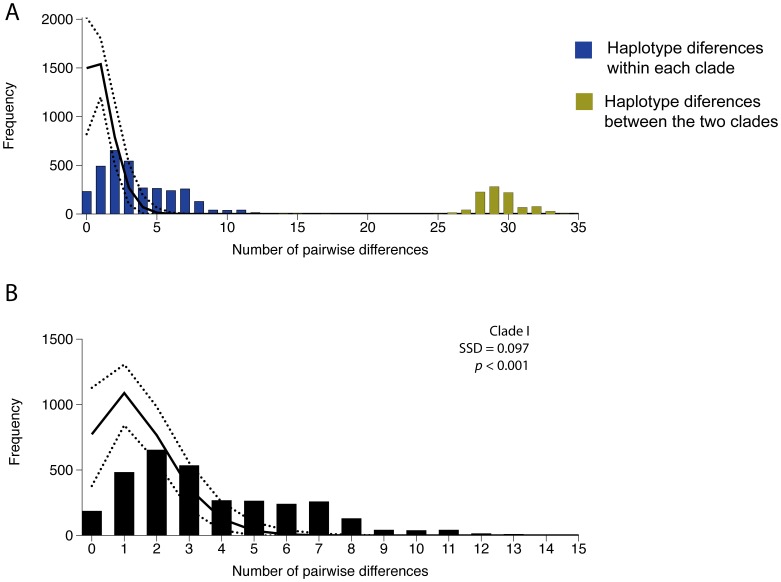
Pairwise mismatch distributions using the CR mtDNA data set.(A) mismatch distribution including all sequences; (B) mismatch distribution including sequences from Clade I only. Vertical bars represent observed frequencies. Upper and lower dashed lines represent the upper and lower 95% limits based on 10000 replicates in Arlequin. Solid line represents the model (expected) frequency.